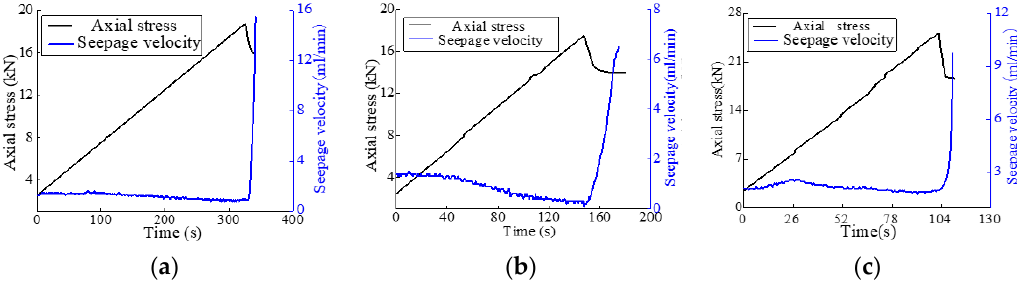
Figure 3. The axial stress-time-seepage curve at different loading rates: ( a ) the curve of stress-time-seepage under 50 N/s loading rate; ( b ) the curve of stress-time-seepage under 100 N/s loading rate and ( c ) the curve of stress-time-seepage under 200 N/s.